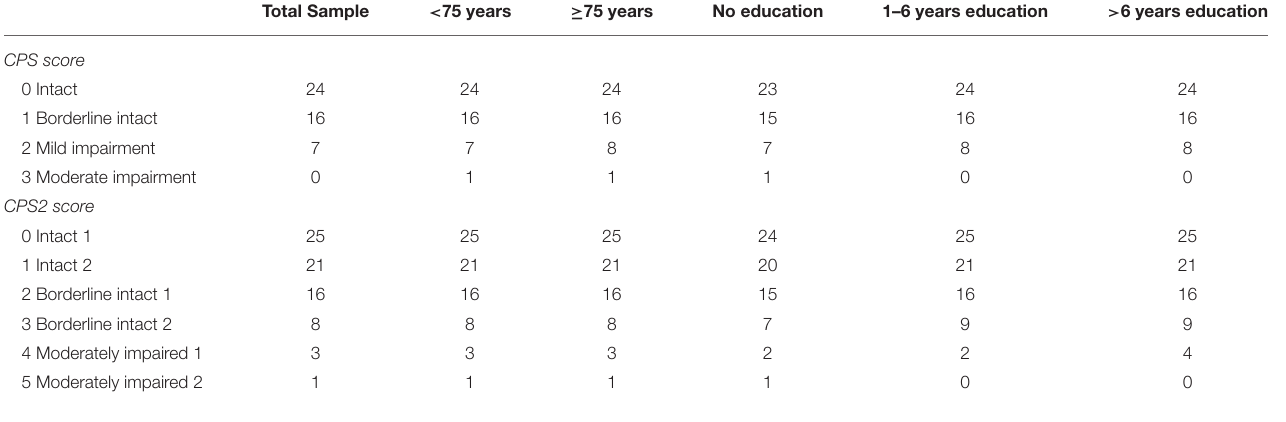
TABLE 3 | Equivalent MoCA scores for each CPS and CPS2 score in three education groups and two age groups.